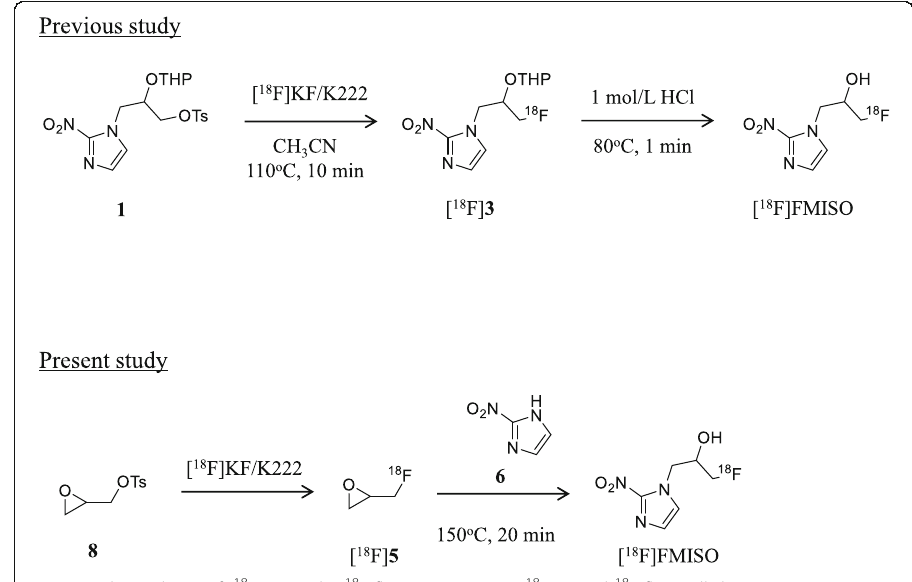
Fig. 2 Radiosynthesis of [ 18 F]FMISO by 18 F-fluorination using [ 18 F]F − and 18 F-fluoroalkylation using [ 18 F]epifluorohydrin ([ 18 F]5). In this study, after the [ 18 F]F − solution was dried, a solution of 8 (3.5 mg) in o - dichlorobenzene (0.15 mL) was added to a reaction vial containing dry [ 18 F]F − . The resulting [ 18 F]5 was distilled under an atmosphere of nitrogen, and transferred to another reaction vial containing 6 (2 mg) and 1 mol/L NaOH (18 µL) in anhydrous DMF (0.25 mL) maintained at -15 °C. After 2 min of trapping of [ 18 F]5, the reaction mixture was heated at 150 °C for 20 min to obtain [ 18 F]FMISO